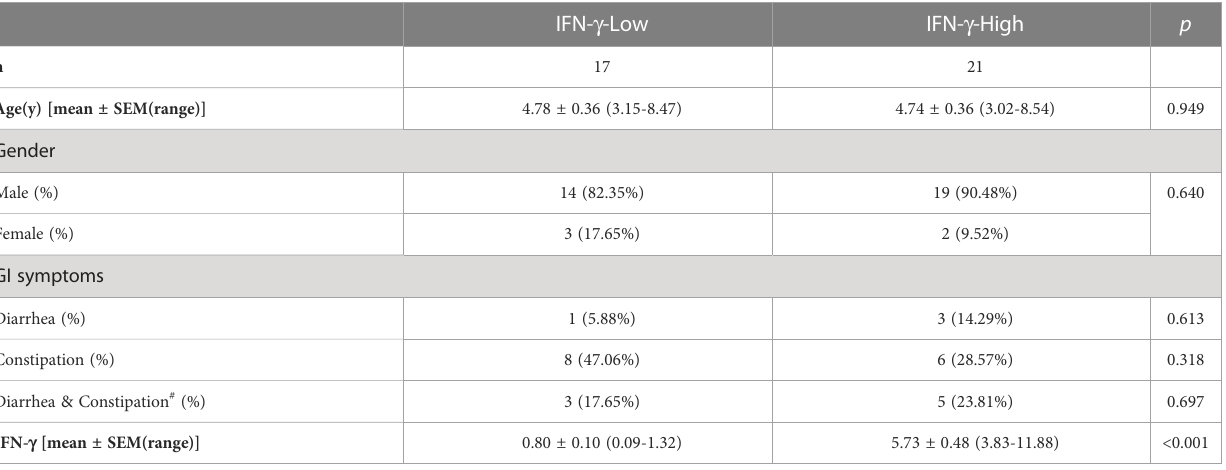
TABLE 1 Characteristics of the enrolled